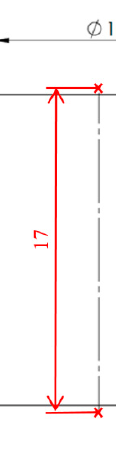
Figure 3. Drawing of compression specimen. The distance shown in red refers to the dies.